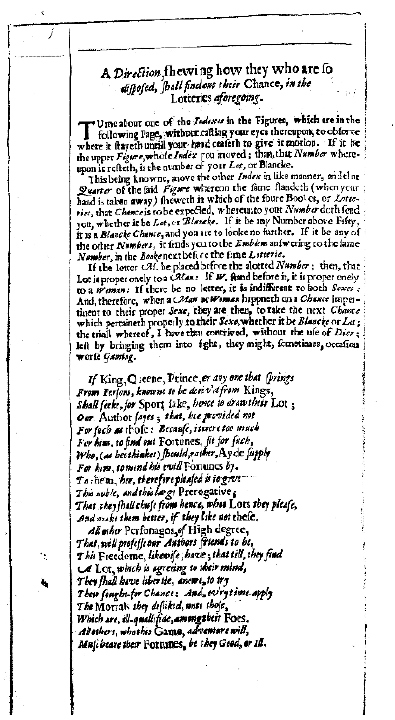
Figure 3: Instructions for use. A Collection of Emblemes, Ancient and Moderne … Printed by A[ugustine] M[athewes] for Robert Milbourne, and are to be sold at the Grayhound in Pauls Church- yard, MDCXXXV), last folio (v)